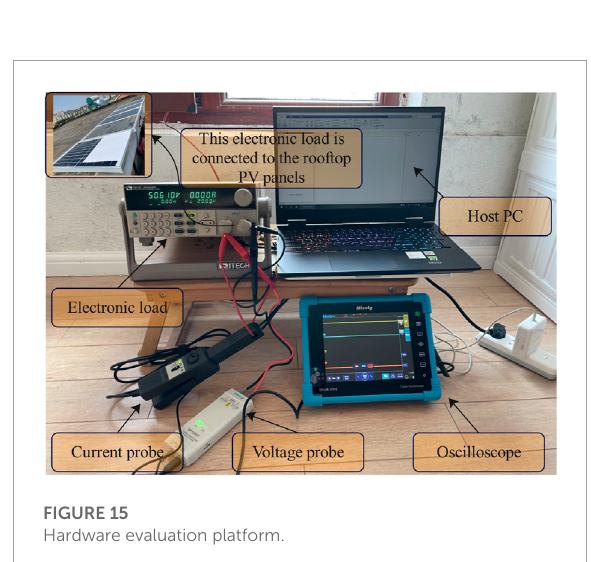
FIGURE 15 Hardware evaluation platform.